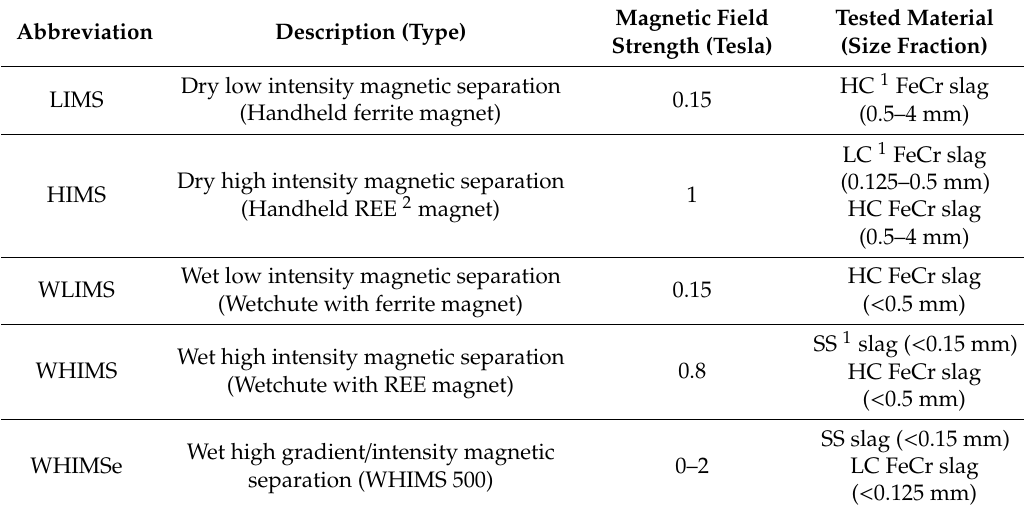
Table 1. Magnetic separation techniques tested in this